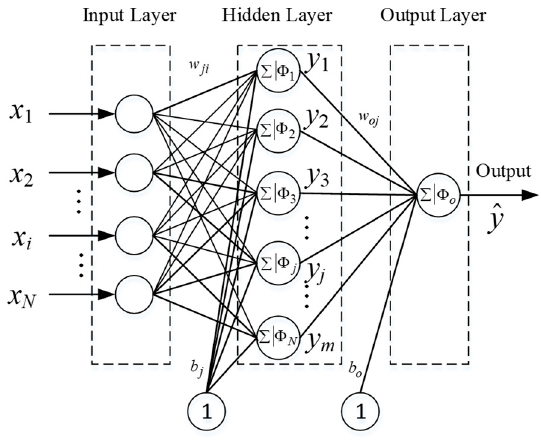
Figure 1. One hidden layer MLP with one output.